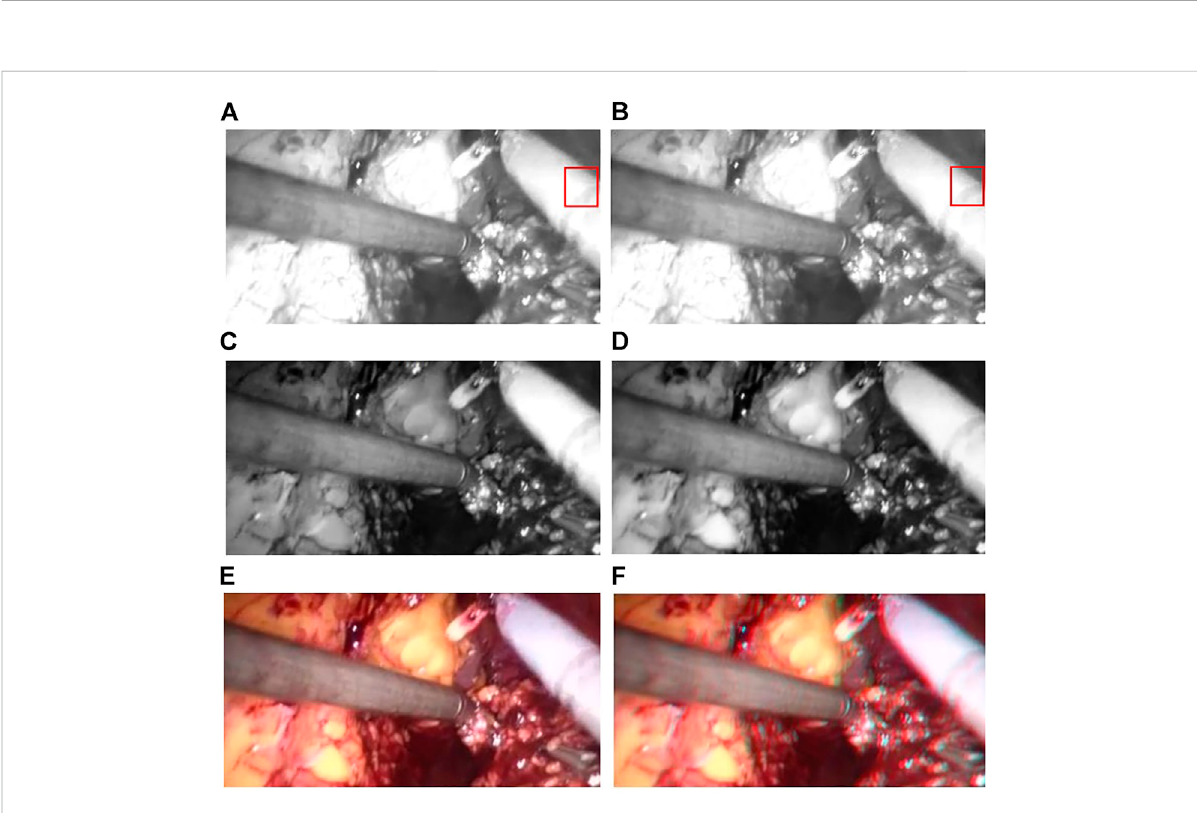
FIGURE 14 3D display of color difference; (A) Red Component; (B) Offset Red Component; (C) Blue Component; (D) Green Component; (E) Raw endoscope image; (F) 3D